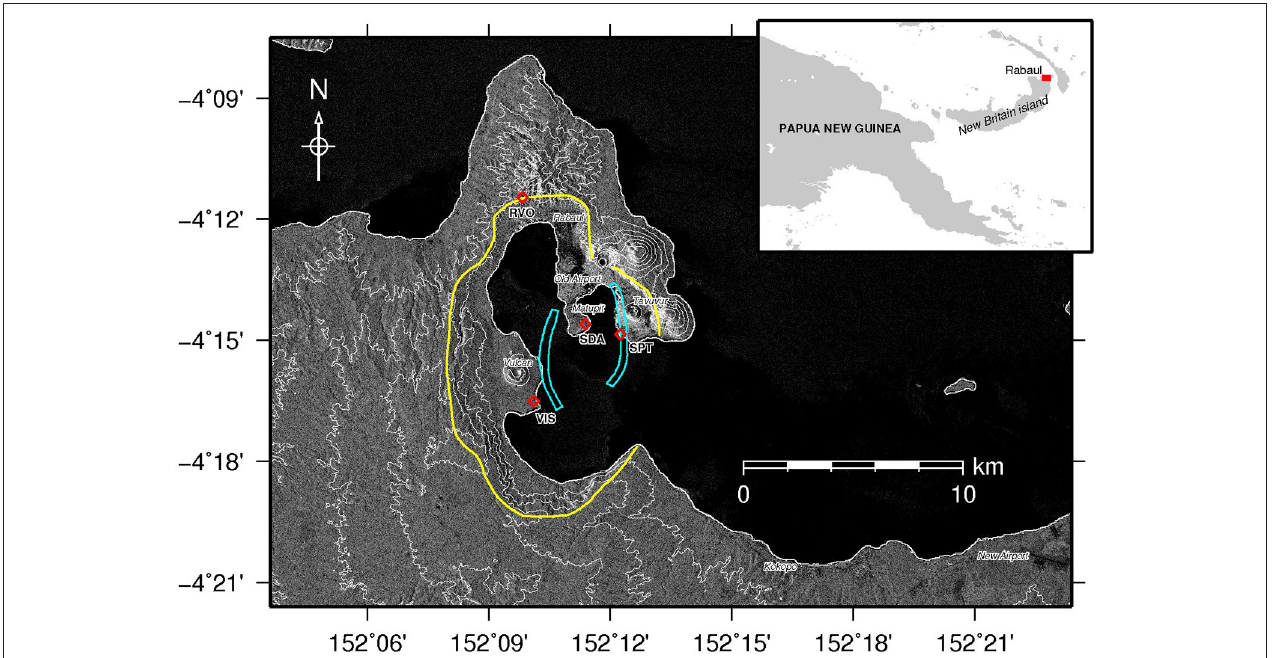
FIGURE 2 | Map of the Rabaul Caldera labelled with points of interest mentioned in the text. Yellow line indicates the general topographic rim of the nested caldera complex. Cyan polygons outline the two zones of concentrated seismicity between 1971 and 1992 occurring above 2km depth that Saunders (2001) used to infer the presence of a ring fault. Locations of GNSS monitoring stations are plotted as red diamonds. The GNSS monitoring station “RVO” is situated at the Rabaul Volcano Observatory (RVO) headquarters. Background image is an ALOS-PALSAR radar backscatter image captured on 5th December 2009. Topographic contours at 100m elevation intervals are shown as white lines. Inset map shows the location of Rabaul within New Britain island, Papua New Guinea.